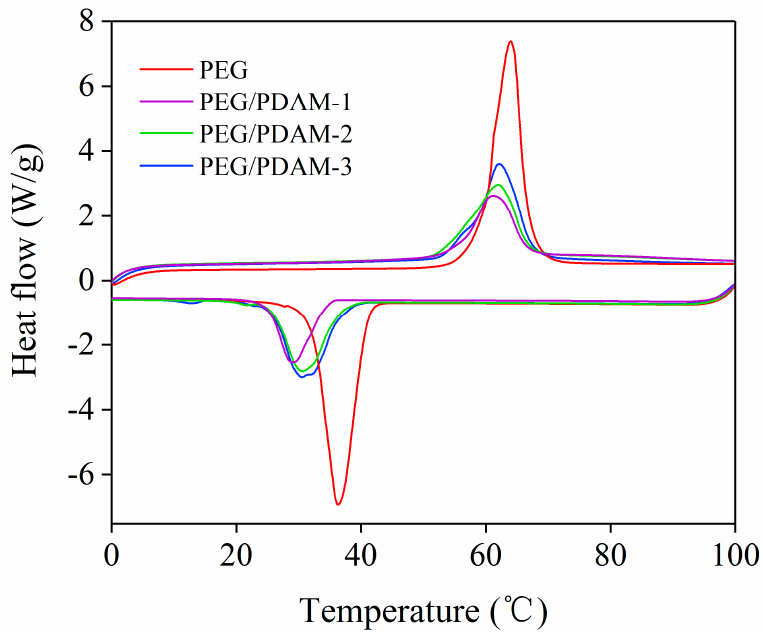
Figure 7. DSC curves of PEG and the samples.